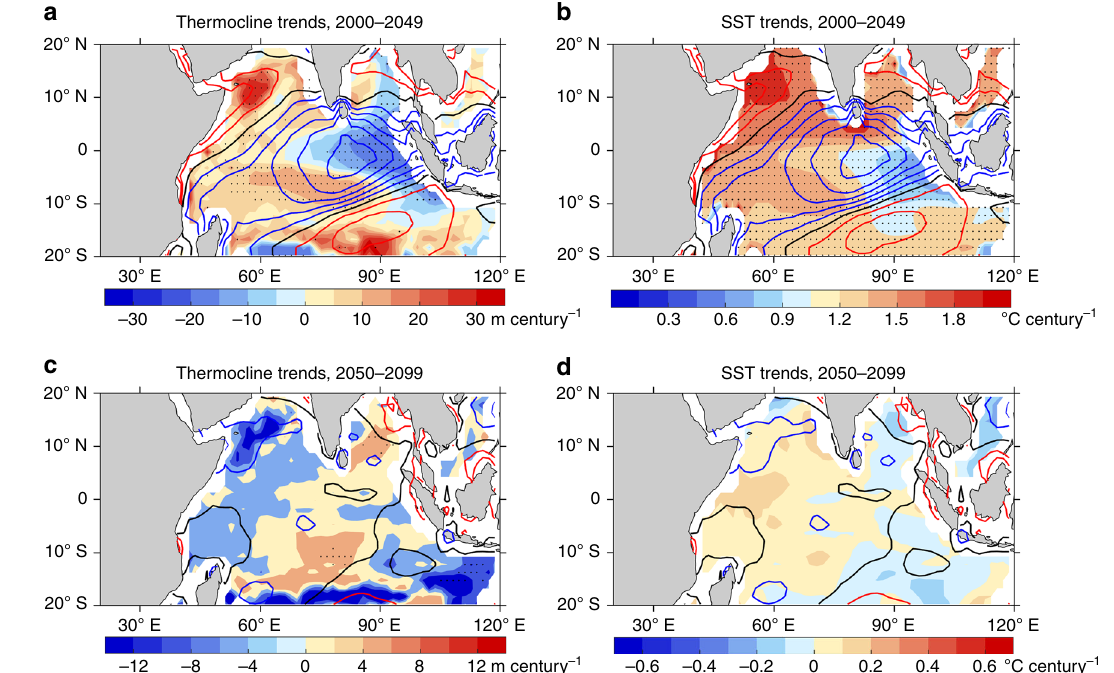
Fig. 4 Trends in thermocline depth and SST over the tropical Indian Ocean. a Map of thermocline depth trends over 2000 – 2049, i.e., prior to the GMT stabilisation, in the unit of m per century. b The same as a , but SST (degree Celsius per century). The trends in zonal wind stress over each time period are also indicated at intervals of 0.005 Pa. Blue, red, and black contours indicate easterly, westerly, and zero zonal wind stress trends, respectively. c , d The same as a , b , but for the GMT stabilisation period (2050 – 2099). Stippled areas indicate statistical signi fi cance above the 95% con fi dence level. All